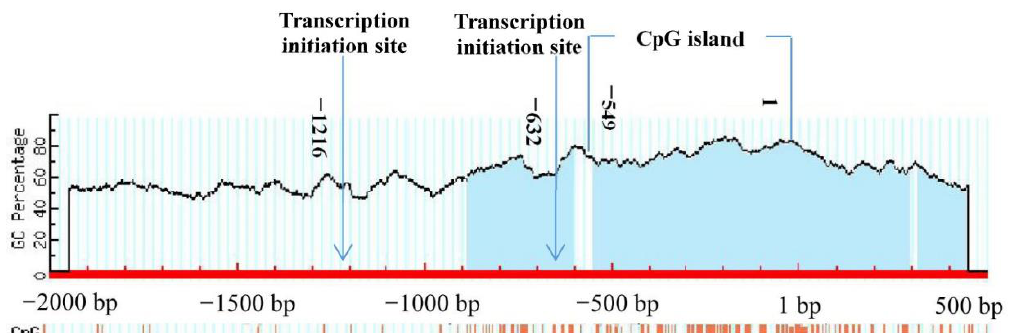
Figure 1. A region of DNA with a high G_C content (greater than 50%) and observed CpG_expected CpG ratio of greater or equal to 0.6 (CpG islands) predicted in the bone morphogenetic protein 7 ( BMP7 ) promoter. Note that the site of “1 bp” means the initiation codon (ATG). The − 2000 bp indicator means 2000 bp in the upstream region of the transcription start site, and the 500 bp indicator means 500 bp in the downstream region of the transcription start site.